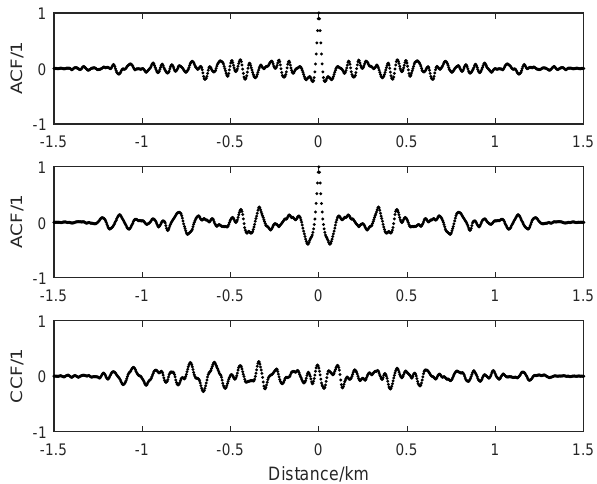
Figure 4. Properties of the residual deviations shown in Fig. 3: (top) auto-correlation function for the off-resonant wavelength residual deviations, (middle) auto-correlation function for the on-resonant wavelength residual deviations, and (bottom) cross-correlation function for the two sets of residual deviations.